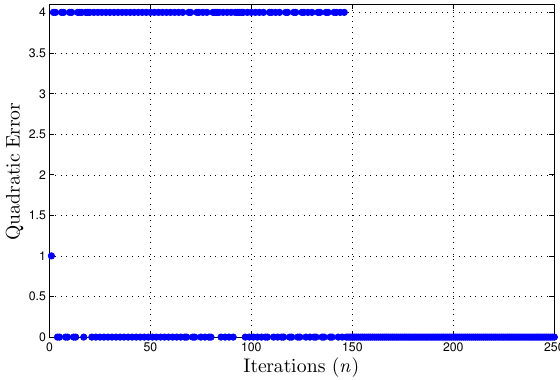
Figure 7. Quadratic error during training using the XOR dataset, floating point implementation.